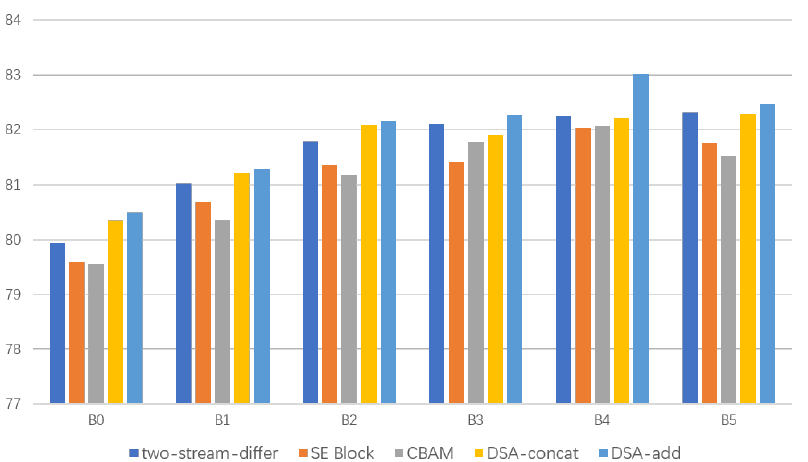
Figure 8. Effect of attention type on multi-modal feature fusion problem. SE-Block and CBAM don’t work and are even harmful. DSA-add performs best over all model size. DSA-concat is slightly lower than DSA-add on model